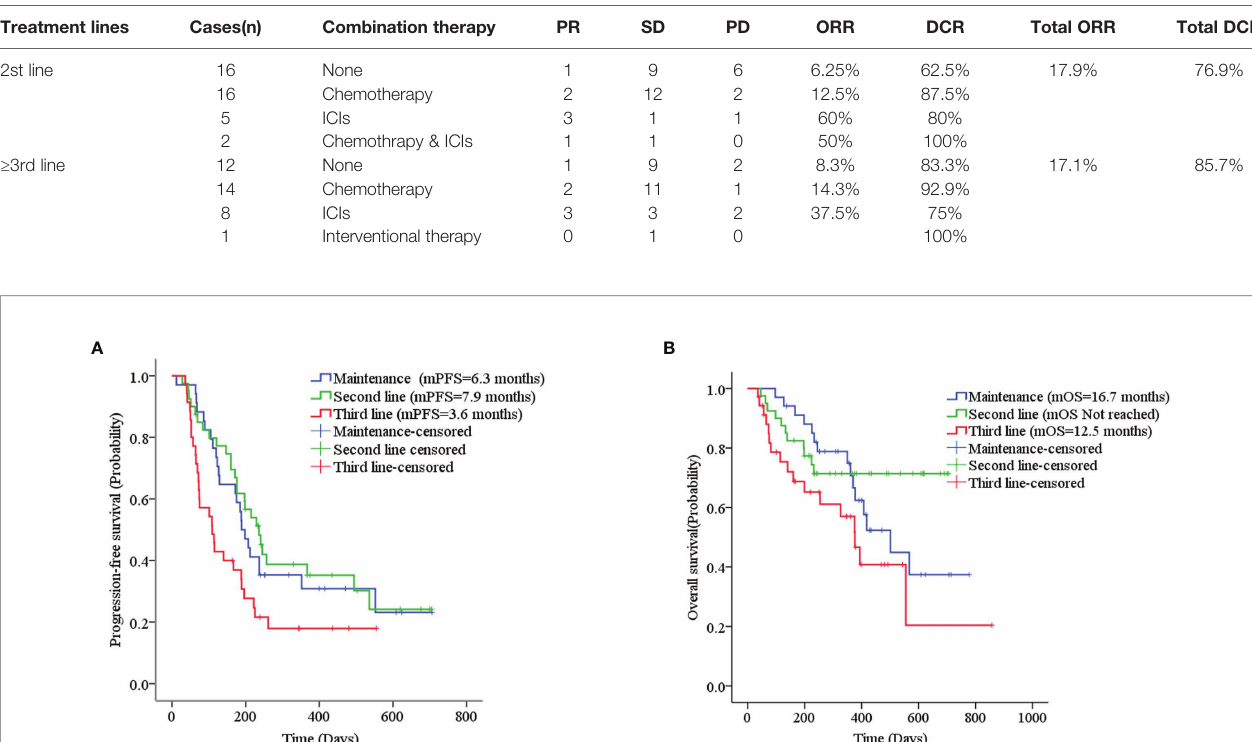
TABLE 2 | Observation of short-term ef fi